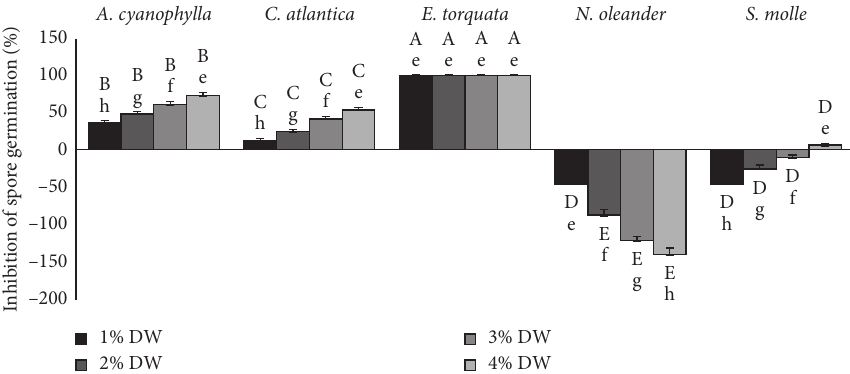
Figure 2: Effect of different plant DW percentages on M. scaettae spore germination. Plant species and extract concentration had significant effects on the percentage of inhibition of spore germination (One-way ANOVA, p < 0 . 05). Each bar represents the mean of four replicate plates per concentration. Within each plant species, bars followed by the same lowercase letters indicate no significant differences among extract concentrations, while within each concentration, bars followed by the same uppercase letters indicate no significant differences among plant species (Bonferroni tests, p < 0 . 05). Error bars represent standard